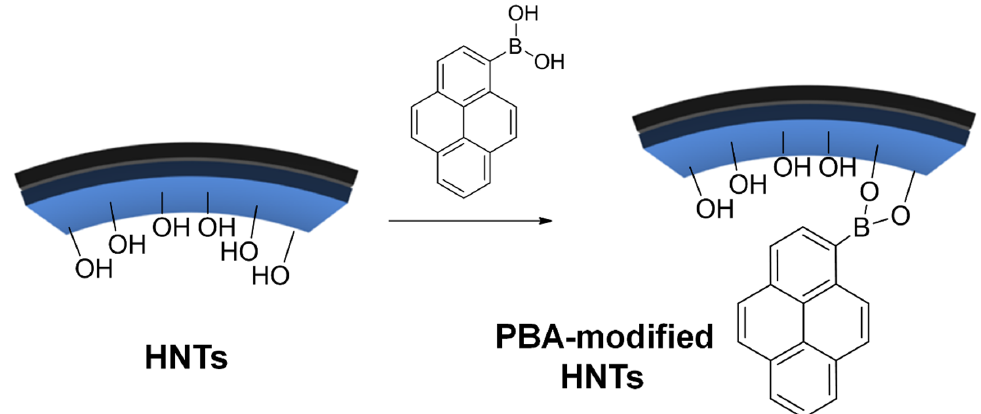
Figure 7: Selective modification of the inner surface by 1-pyrenylboronic acid conducted by our group [35]